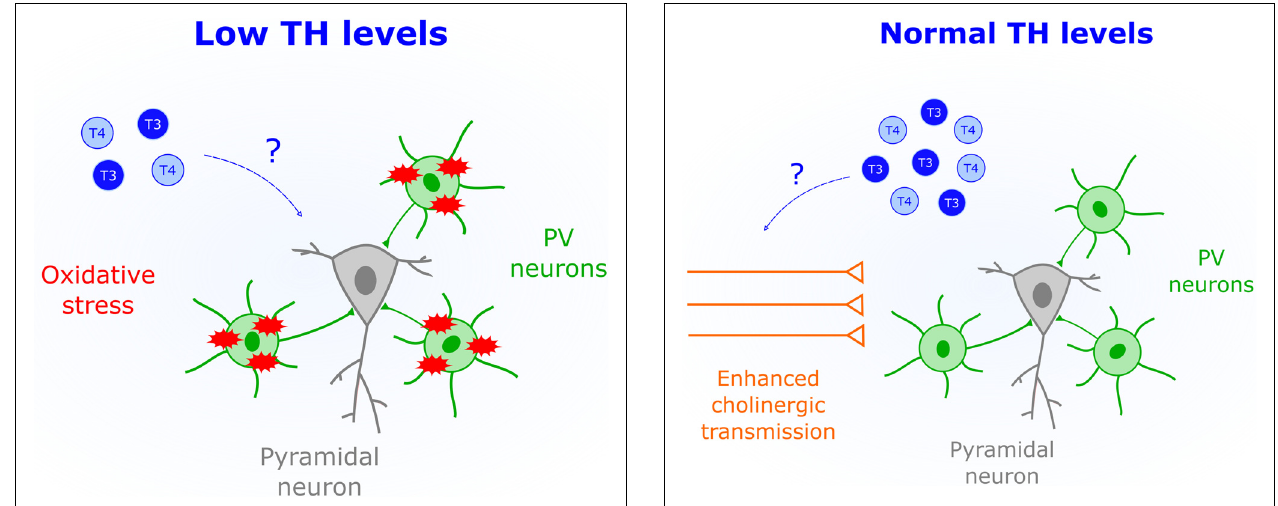
FIGURE 3 | Low levels of THs (blue) correlate with increased oxidative stress. The schematic shows that parvalbumin-positive cells (PV), but not pyramidal cells, are particularly sensitive to oxidative stress, which could mediate brain deficits triggered by low perinatal TH levels.